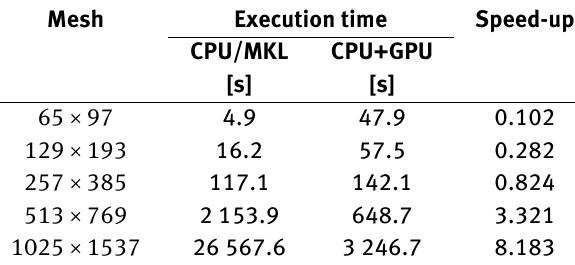
Table 4: Execution times and the speed-up of computations (CPU/MKL – author’s own program, CPU+GPU – the CUDA envi-